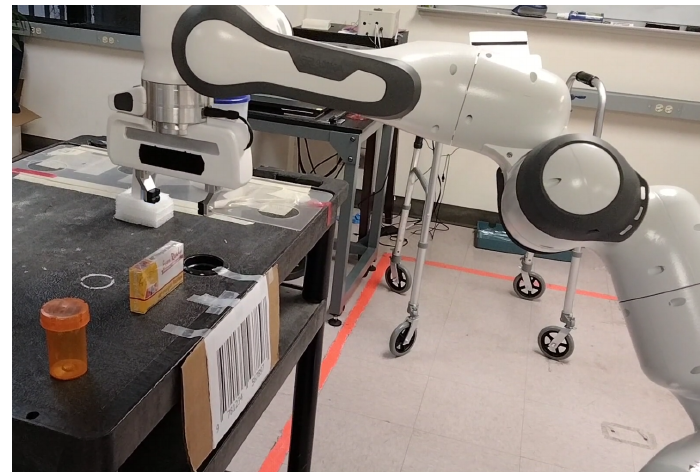
Figure 5. Barcodes placed below the items in front of the MINA robot.